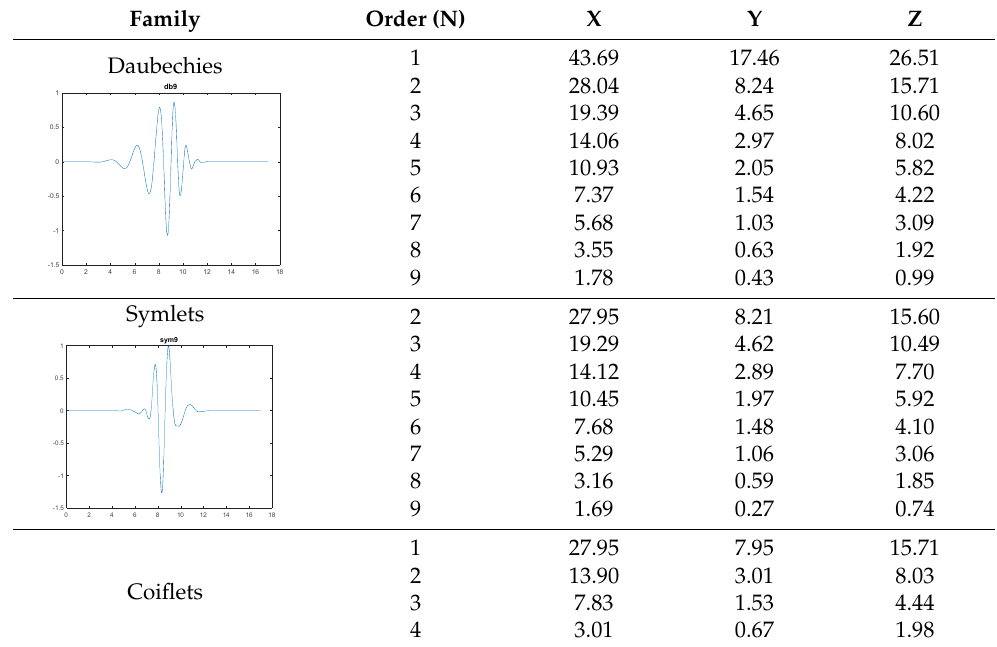
Table 2. DEV % values for each mother wavelet and axis. Family